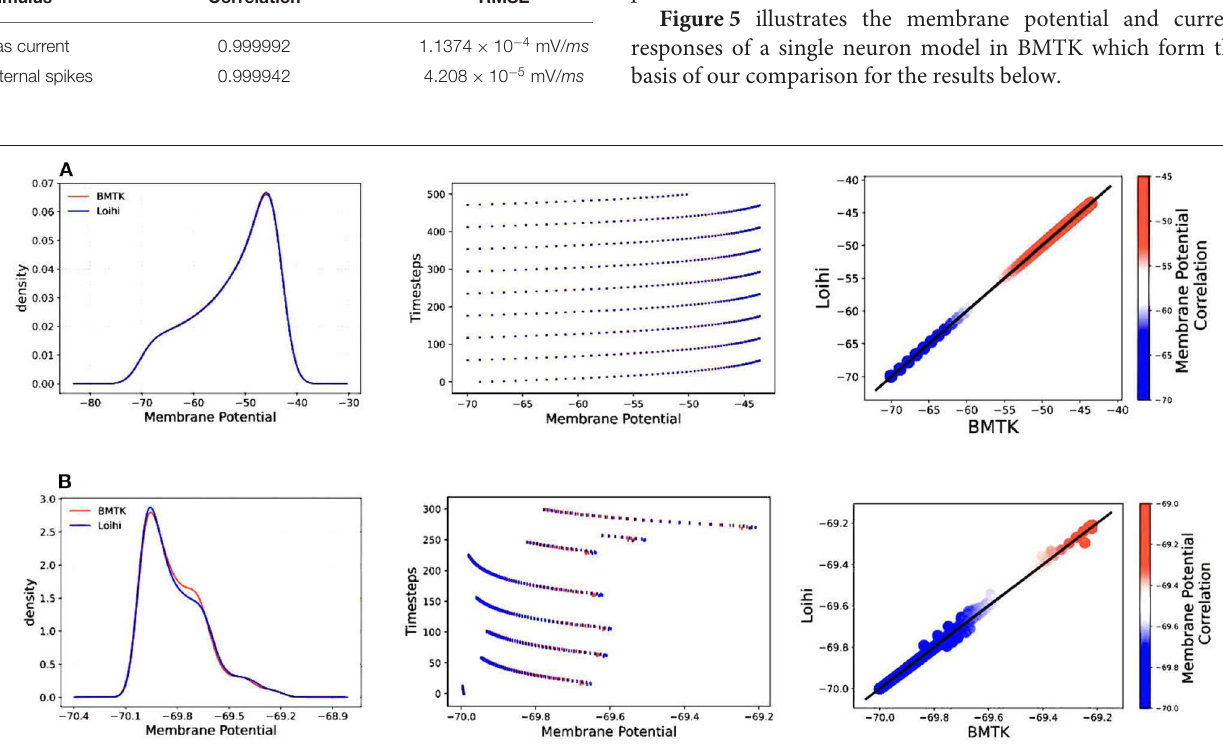
Frontiers in Neuroinformatics |